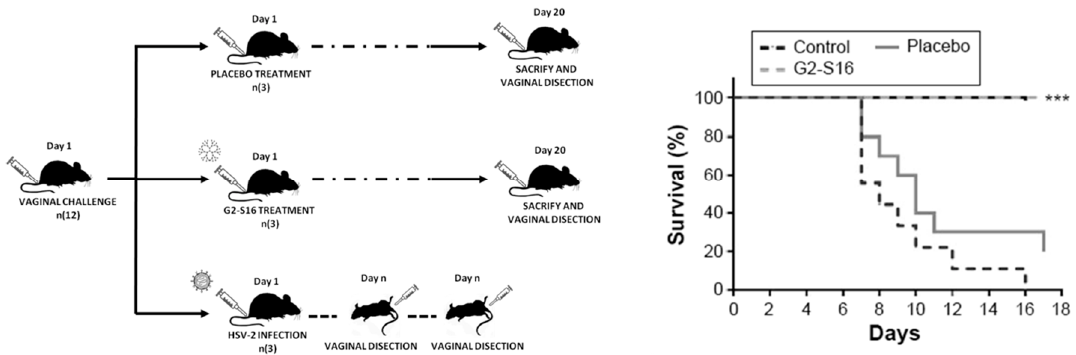
Figure 5. Summary of the experiment performed to check the G2-S16 dendrimer effectivity against HSV-2 infection. The G2-S16 dendrimer prevented HSV-2 vaginal infection even when using high viral doses. The Kaplan-Meier graph shows the survival rates for every group. Dendrimer-based gels containing 3% G2-S16 dendrimer were significantly more protective than the gel containing the vehicle alone (*** p < 0.001 when comparing treated versus placebo groups). Control group: HSV-2 infection control. Placebo group: gel vehicle only [18].